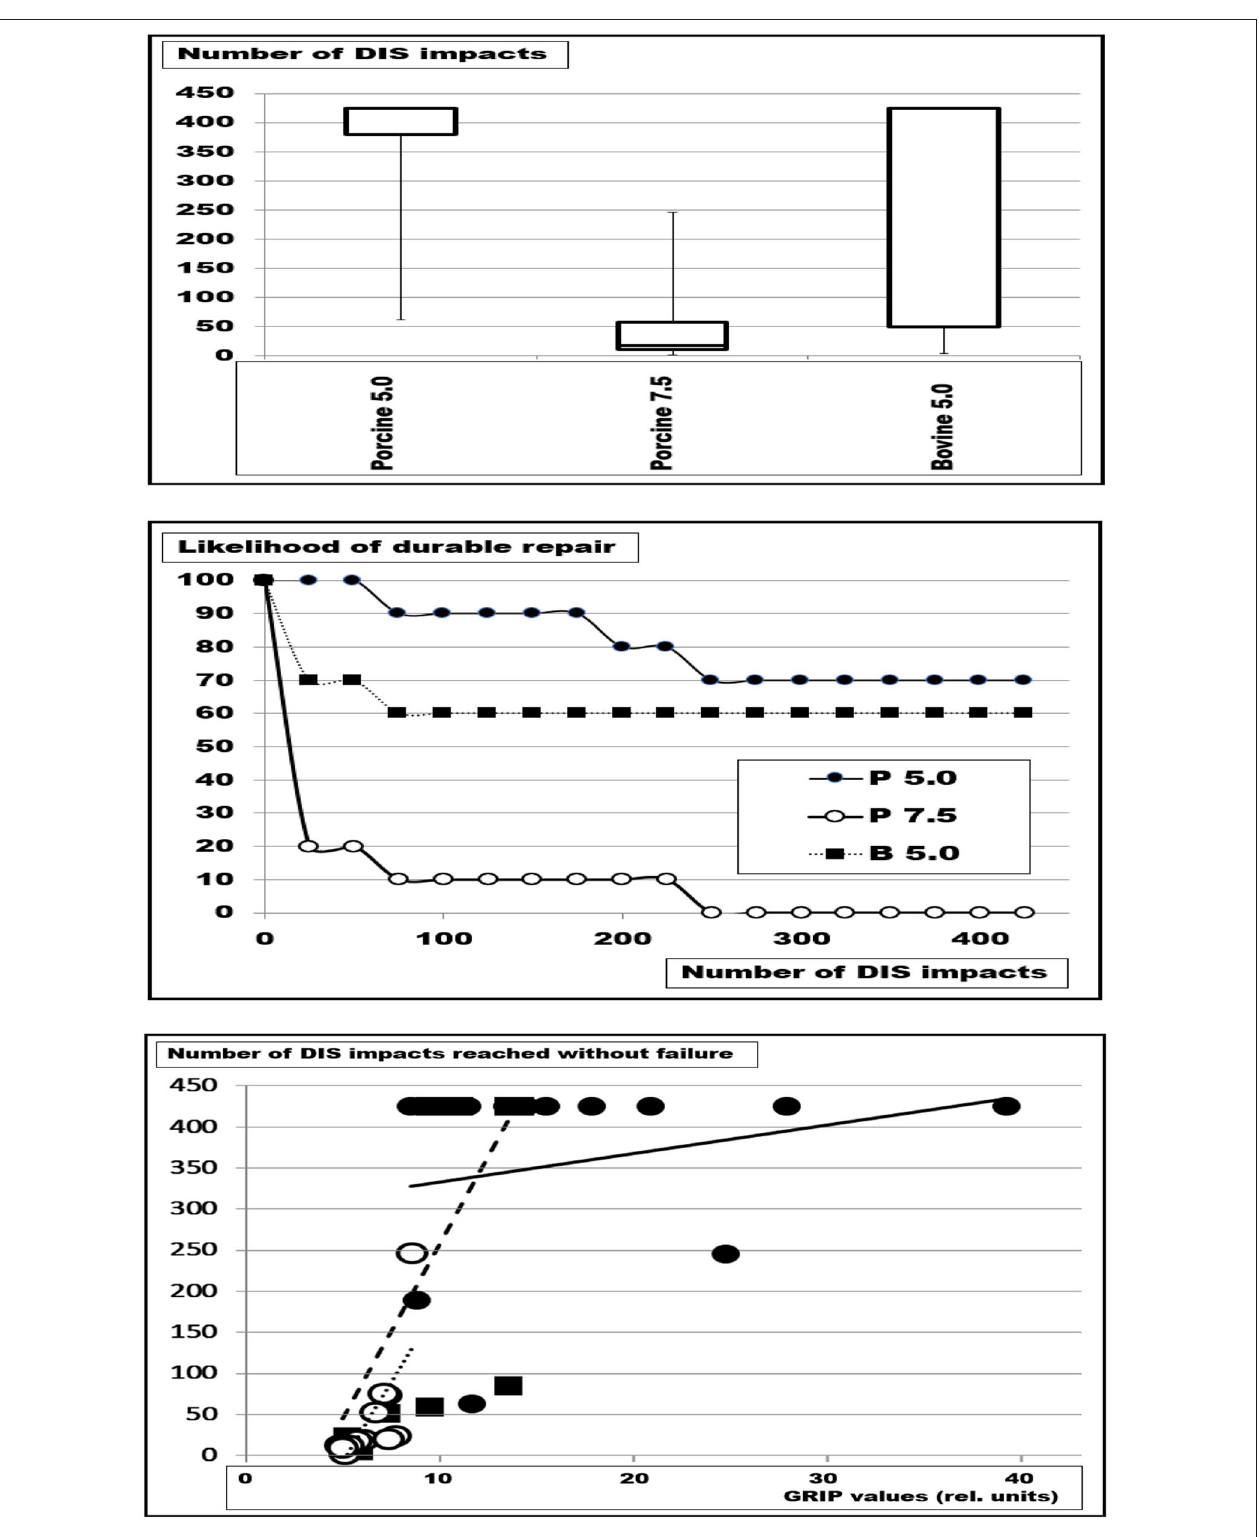
FIGURE 2 | Box-and-whisker plots (top) , the likelihood of durable repairs (middle) , and the number of DIS impacts without failure as a function of the GRIP values adjusted to the distension of the orifice (bottom) . Depicted are the results of bridging of defects with a diameter of 5cm (5) and 7.5cm (7.5) in porcine (P), and bovine (B) tissues with square Dynamesh® Cicat meshes 15cm x 15cm without fixation. The symbols in the lower panel correspond to those in the middle panel. The trendline in the lower panel for P 5 is solid, that for P 7.5 is dotted and that for B 5 is broken. It can be seen that the trendlines for P 7.5 and B 5 run in parallel. The solid line increases with increasing GRIP reaching a durable repair at GRIP values above